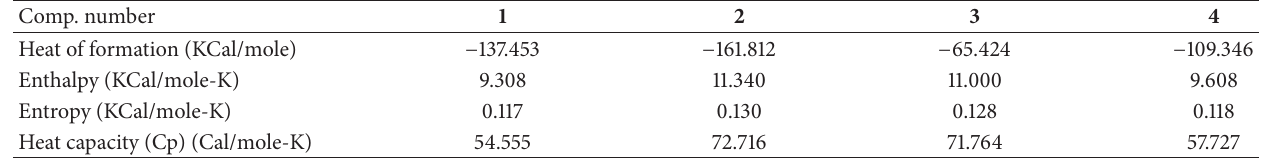
Table 8: Computed thermodynamic parameters (at 298 K) of complexes 1–4 .